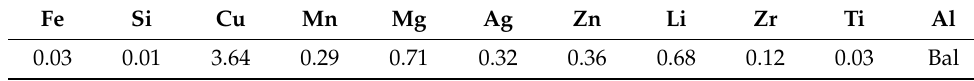
Table 1. Chemical compositions of the Al–Li alloy (wt.%) [19].